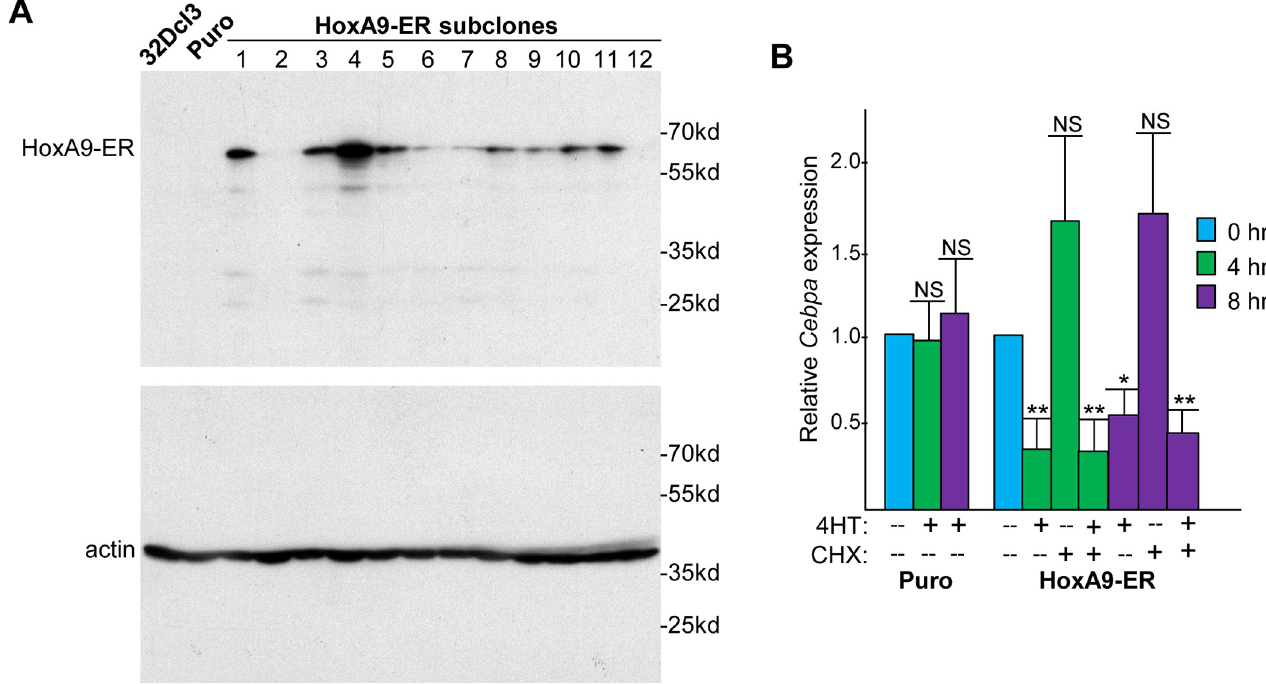
Fig 2. HoxA9-ER directly represses Cebpa gene expression in myeloid cells. A) Total cellular proteins from parental 32Dcl3 cells, pooled 32Dcl3 MIPuro cells, and twelve 32Dcl3 MIPuro-HoxA9-ER subclones were subjected to Western blotting using anti-rabbit ER α anti-serum, followed by stripping the blot and reprobing with β -actin antibody. B) Total cellular RNAs from these cells prepared after 0, 4, or 8 hr of culture in IMDM/HI-FBS/IL-3 media alone, with 200 nM 4-hydroxytamoxifen (4HT), with 50 μ g/mL cycloheximide (CHX), or with both were subjected to quantitative PCR analysis for Cebpa expression relative to mS16 mRNA. CHX was added 30 min prior to 4HT when combined (mean and SD from three independent experiments).